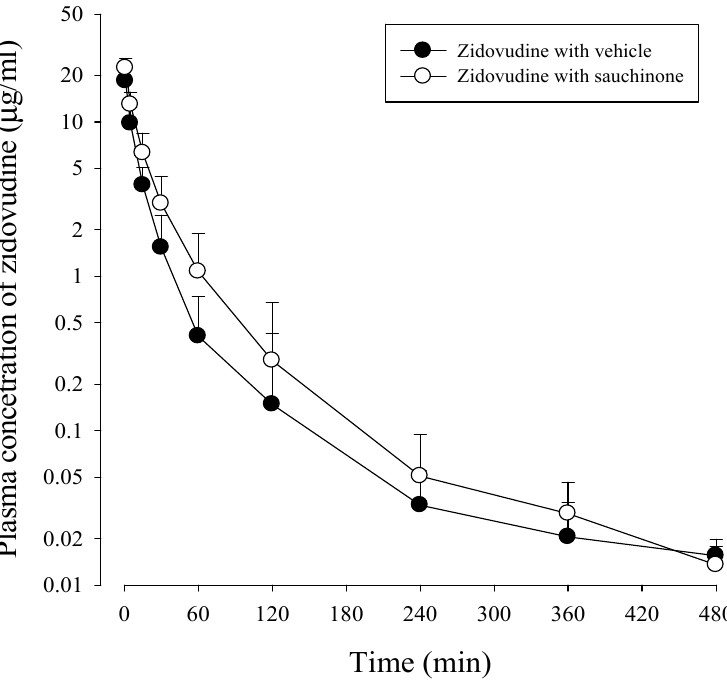
Figure 4. Plasma concentrations of zidovudine after intravenous administration of 15 mg/kg zidovudine with ( ○ ; n = 11) and without ( ● ; n = 11) oral administration of 100 mg/kg sauchinone. Table 2. Means (± standard deviations) of pharmacokinetic parameters of zidovudine after intravenous administration of 15 mg/kg zidovudine with or without oral administration of 100 mg/kg sauchinone ( n = 11 for each